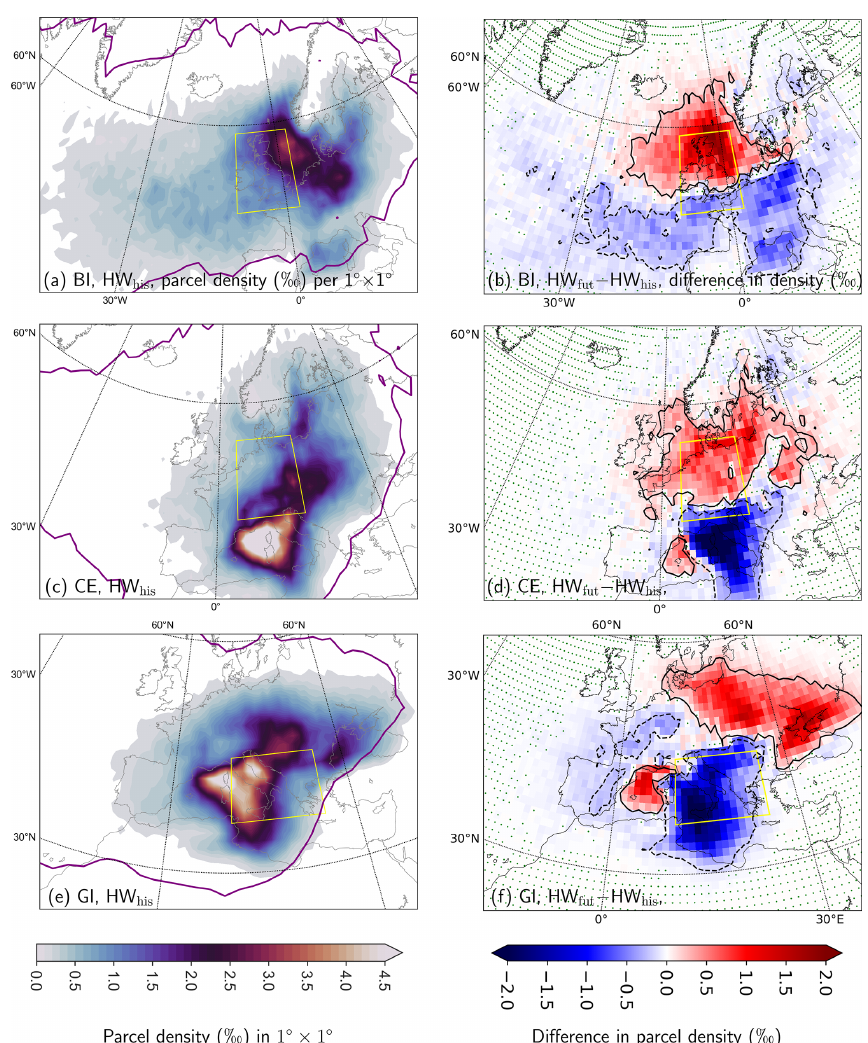
Figure 6. Spatial distribution of the trajectories initialized during heatwaves in (a, b) BI, (c, d) CE and (e, f) GI. The left column shows the densities of the parcel trajectories (color shading) 3d prior to the heatwaves. The purple contour indicates a parcel density (all trajectories) of 0.1‰ per 1 ◦ × 1 ◦ 7d prior to the heatwave; the right column shows the difference between future trajectory densities 3d prior to the heatwaves HW fut minus the historic ones HW his . Densities (in ‰) are shown by red–blue color shading. The solid (dashed) black contour in panels (b) – (e) marks the + 0 . 2‰ ( − 0 . 2‰) difference in parcel density. The significance of differences in parcel densities was determined with a bootstrap method, obtaining 99% confidence intervals at each grid point and for each period by resampling the original heatwave data 100 times with replacement. Grid points marked by a green dot show no significant difference in parcel densities between the two respective